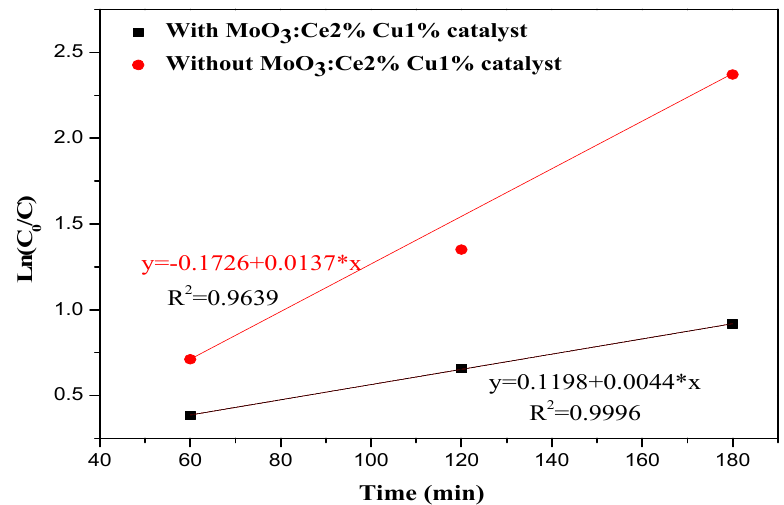
Figure 7. First-order linear plot of ln(C 0 /C) of Eosin-Y versus sunlight irradiation time, without and with MoO 3 :Ce2% Cu1% catalyst thin film for [S] = 40 × 10 − 3 M.